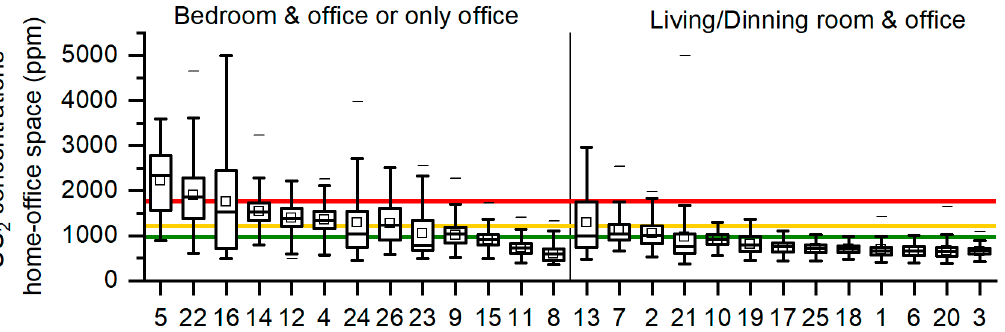
Figure 4. CO 2 concentrations according to the use of the space (Filtered).